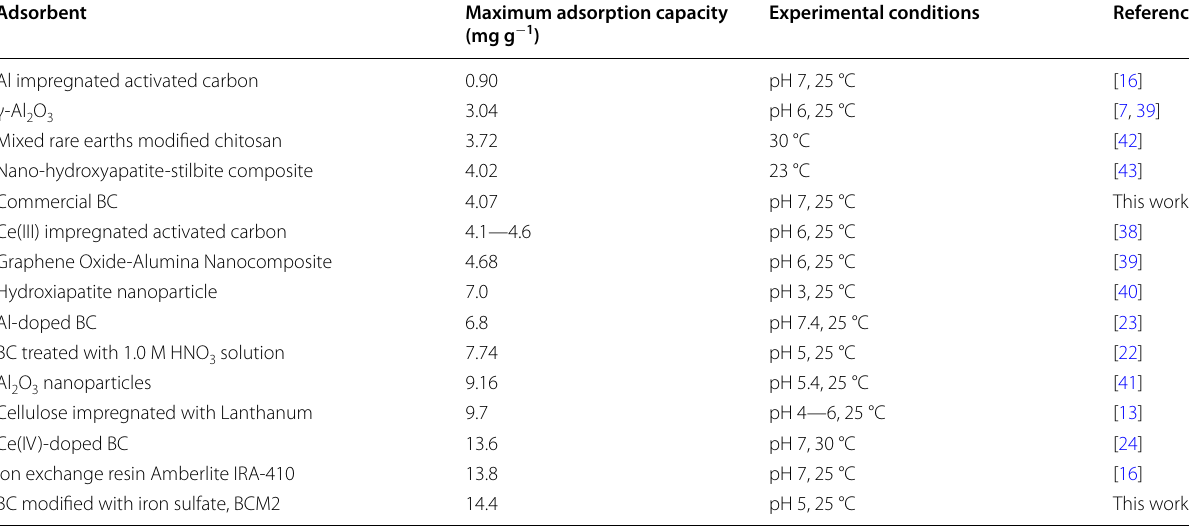
Table 4 Comparison of adsorption capacities of various materials towards fluoride in aqueous solution